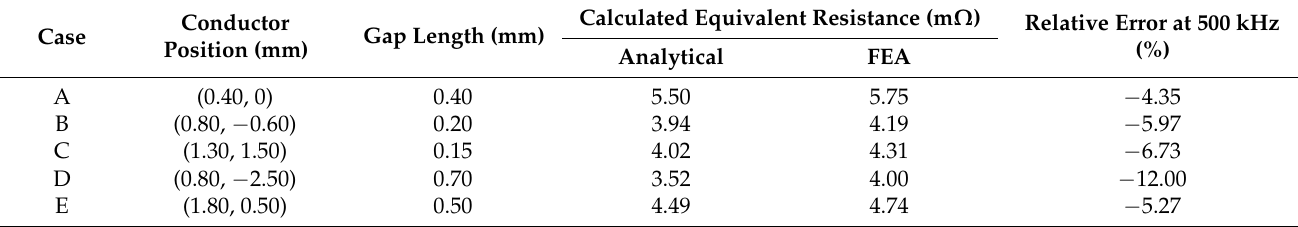
Table 1. Comparison between the analytical and FEA-calculated equivalent resistance of a conductor of position (x, y) from the air gap at a frequency of 500